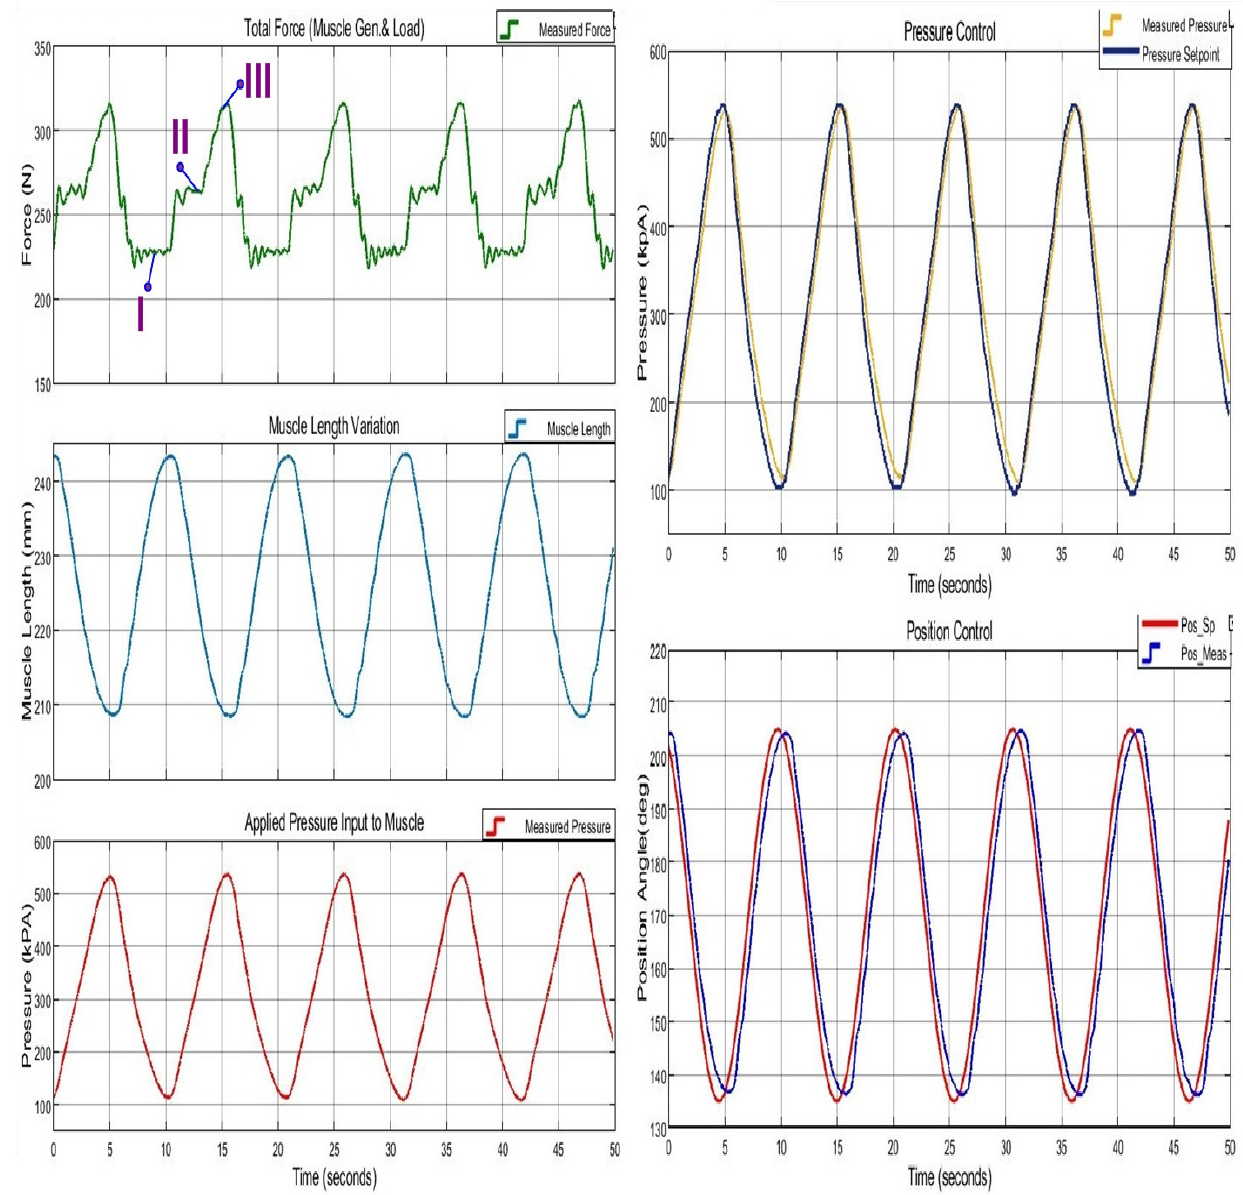
Figure 14. Overview of NARX estimation-based control response at 0.1 Hz sinusoidal trajectory tracking operation. I: isotonic extension, II: isotonic flexion, and III: quasi-isometric contraction. For I F = 229.5 N, II F = 263.1 N, and III F = 315.7 N.